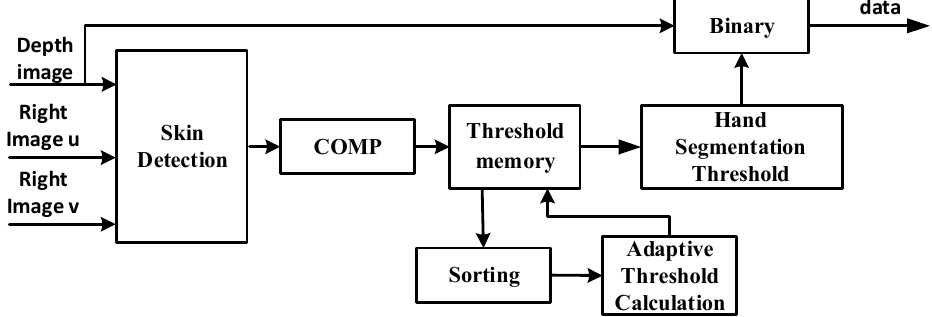
Figure 7. Hardware architecture of hand detection.